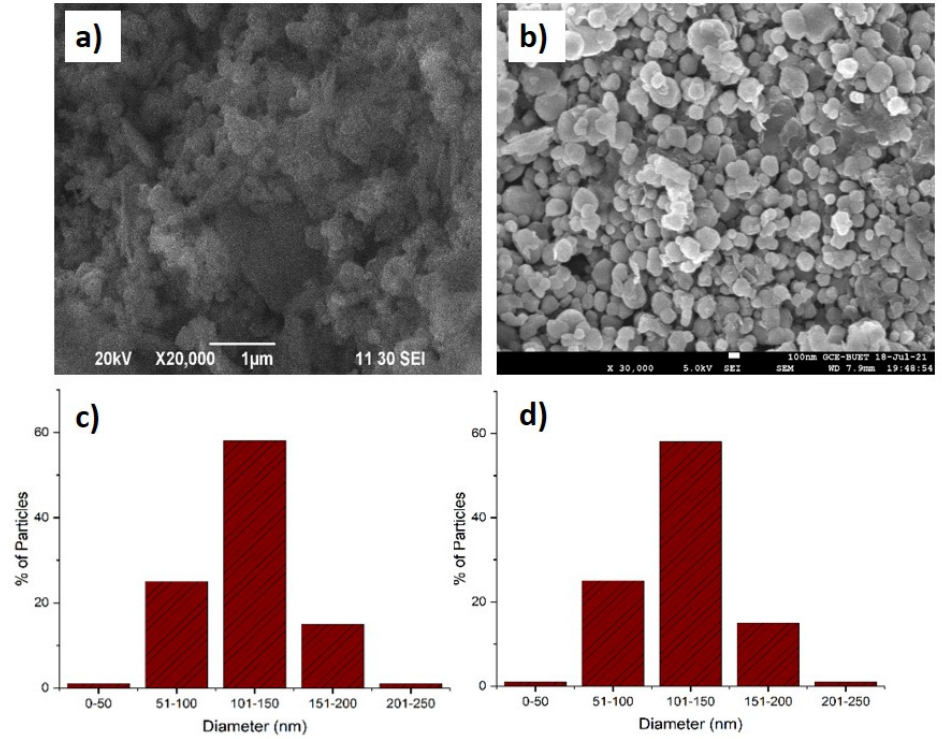
Figure 7. FE-SEM images of ternary nanohybrid ( a ), TP 0.75 CS 0.25 nanocomposite ( b ), histogram of particle size distribution for TiO 2 ( c ), and TP 0.75 CS 0.25 composite ( d ). However, the FE-SEM images of the nanohybrid showed different morphological as- pects compared to the ternary photocatalyst (Figure 7c). The hexagonal shape of the par- ticles was achieved through the fabrication of the novel nanohybrid, confirmed by FE- SEM. The surface also showed no propensity to agglomeration with the majority of parti- cles (44.68%) staying within 101–150 nm particle size. In general, the approximate sizes of the particles were found in a range of 50 to 250 nm. From Figure 7b,c, we can see that about 34% of nanohybrid particle sizes were in the nanoscale range (1–100 nm). However, in the case of the ternary photocatalyst, only 26% of particles were able to duel in this range. Therefore, it can be easily concluded that the obtained nanohybrid particles were at a higher percentage in terms of nanoscale range compared to the ternary photocatalyst. The uniform wrappings of the ternary nanohybrid by long molecular chains of chitosan with greater efficiency were able to prevent agglomeration. This phenomenon explains the lowering of particle size of nanohybrids. The wrapping of the TiO 2 surface with soft and flexible chitosan could also explain the shift in morphology from flaky to hexagonal. This morphological shift also supports the interfacial interaction of ternary with chitosan. In addition, it should be stated that no odd structures were detected on the surface of the nanohybrid, which is highly expected considering the application point of view.